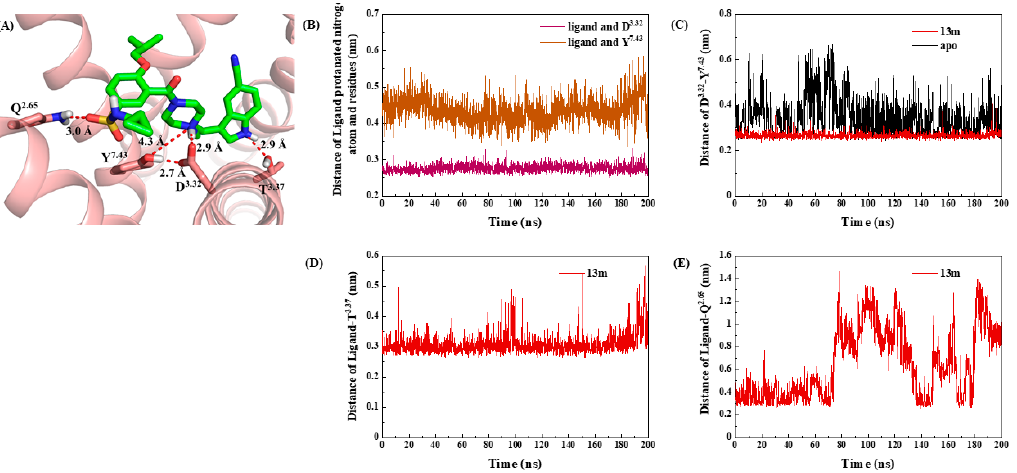
Figure 4. ( A ) The interaction between 13m and D3.32, Y7.43, Q2.65 and T3.37. The ligand is shown as green sticks. 5-HT 1A R and the surrounding residues are in pink. Hydrogen bond interactions are represented as dotted red lines. ( B ) Distance of the ligand with D3.32 and Y7.43. ( C ) Distance between D3.32 and Y7.43. ( D ) Distance between ligand and T3.37. ( E ) The interaction between ligand and Q2.65 in 13m -5-HT 1A R system.